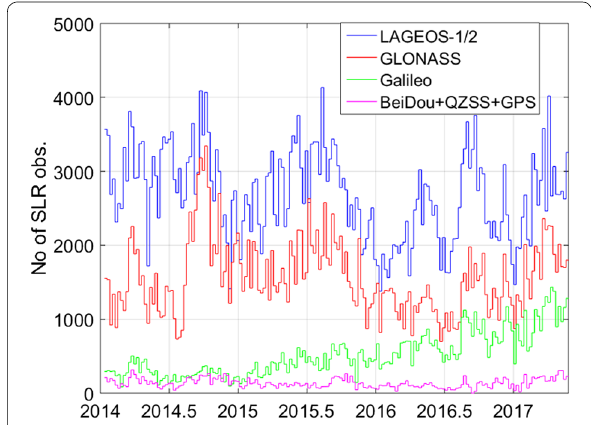
Fig. 2 Number of weekly SLR observations to LAGEOS and GNSS satellites between 2014.0 and